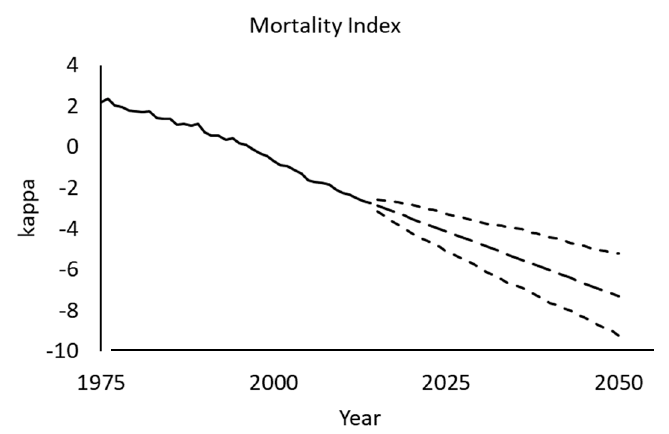
Figure 2. Bayesian Lee–Carter mortality index for 1975 to 2014 (solid line) and projected values with 95% prediction intervals for 2015 to 2050 (dashed and dotted lines).